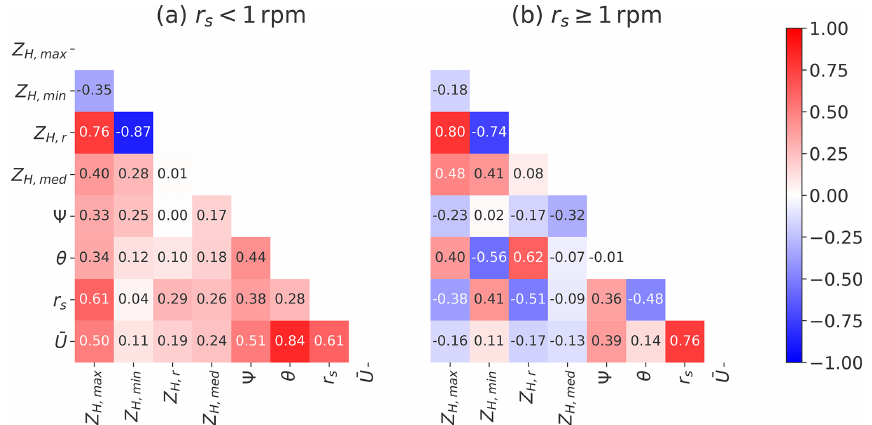
Figure 13. Pearson linear correlation coefficient heat map matrices between radar returns, resampled to a temporal resolution of 10min (maximum Z H , max , minimum Z H , min , difference Z H , r , median Z H , med ) and WT1 orientation (cid:57) , blade pitch angle θ , rotor speed r s and average wind speed ¯ U . The correlation matrix (a) is computed with the measurements when the rotor speed r s is less than 1rpm and (b) when r s is equal to or higher than 1rpm. Some corresponding regression line fits are shown in the scatterplots of Fig.